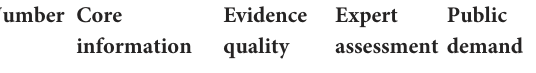
TABLE 8 The correlation between smoking and risks of female digestive system